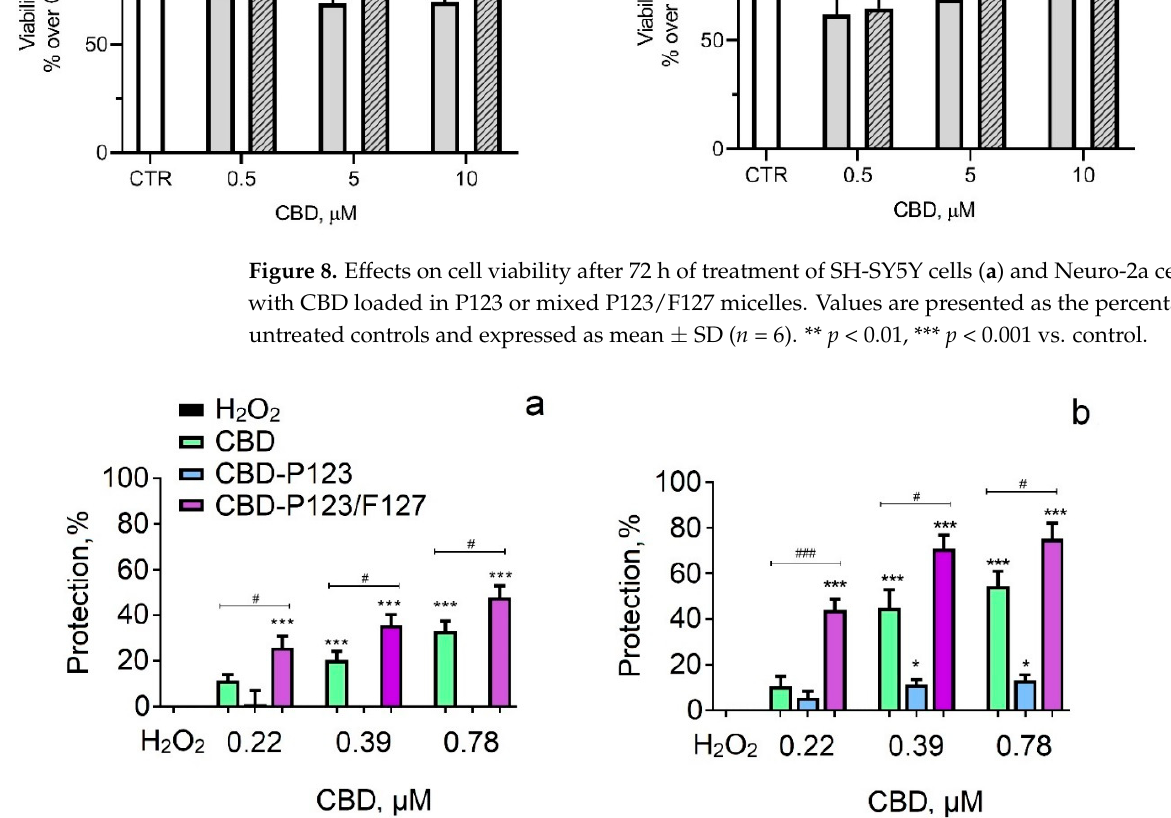
Figure 9. Protective effects of pure CBD and CBD loaded in P123 and mixed P123/F127 micelles in a model of H 2 O 2 -induced oxidative damage in SH-SY5Y ( a ) and Neuro-2a ( b ) cells. Data are presented as means from three independent experiments ± SD ( n = 8). * p < 0.05, *** p < 0.001, vs. H 2 O 2 group